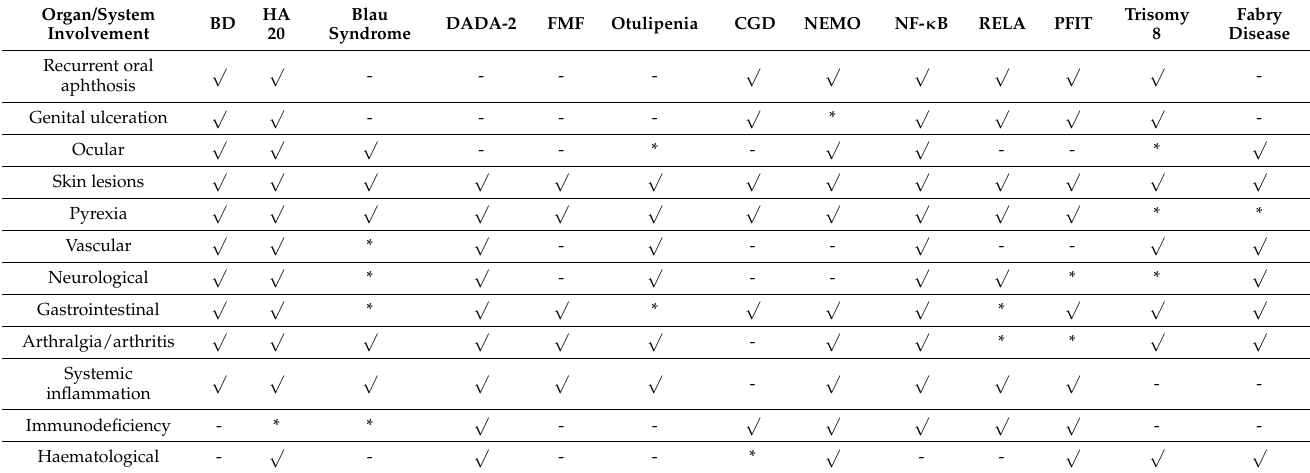
Table 3. Comparison of clinical manifestations in BD and monogenic